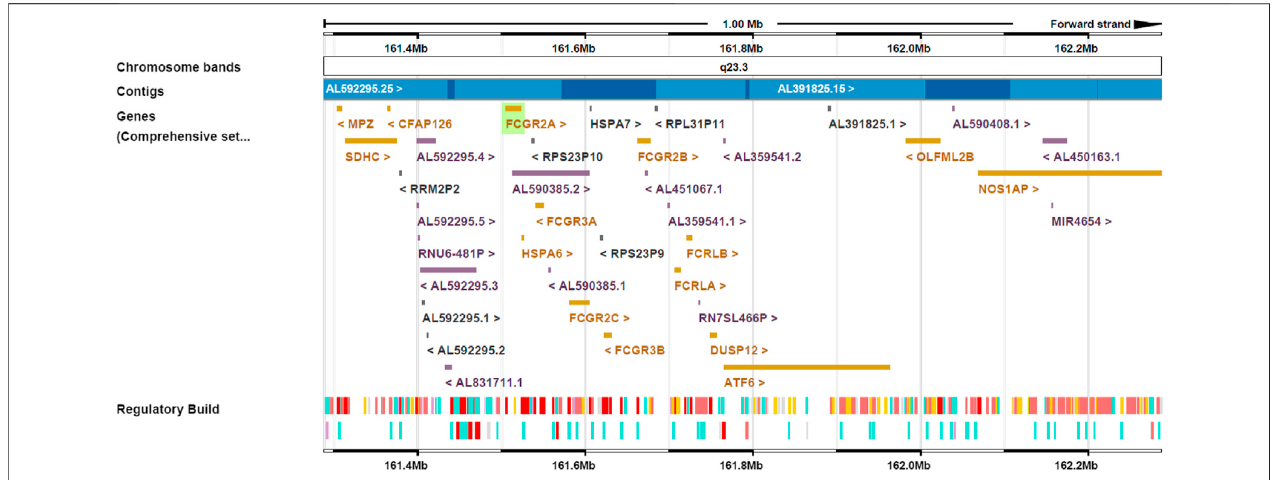
FIGURE 1 | Genomic region of the low-af fi nity Fc γ receptor cluster on human chromosome 1q23.3. FCGR2A, FCGR2B and FCGR2C are located on the forward strand and FCGR3A and FCGR3B on the reverse strand.